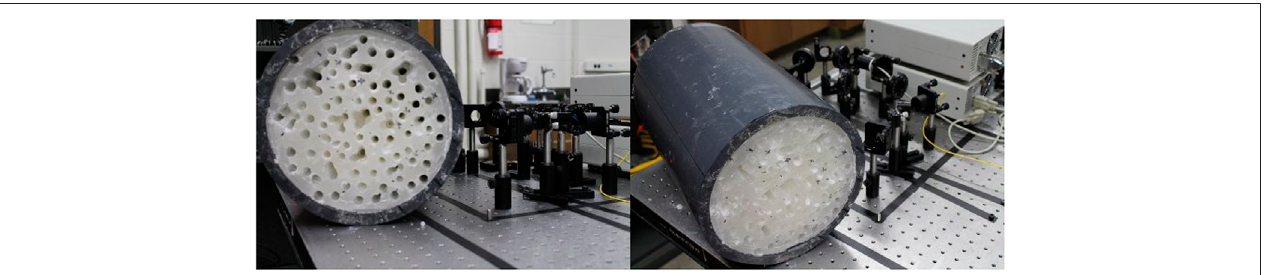
FIGURE 4 | The pictures show a large pipe fi lled with candle to observe TAL in the microwave spectrum. The random air-holes are drilled into the candle along the pipe to create the required random refractive index contrast across the waveguide.